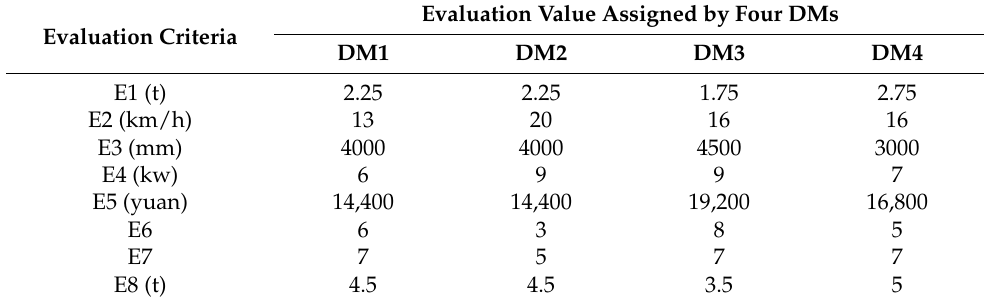
(b) Scheme Value Assessment of Evaluation Criteria on the Economy Evaluation